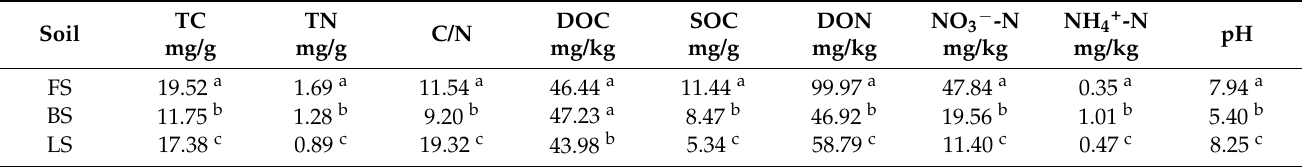
Table 1. Soil properties.